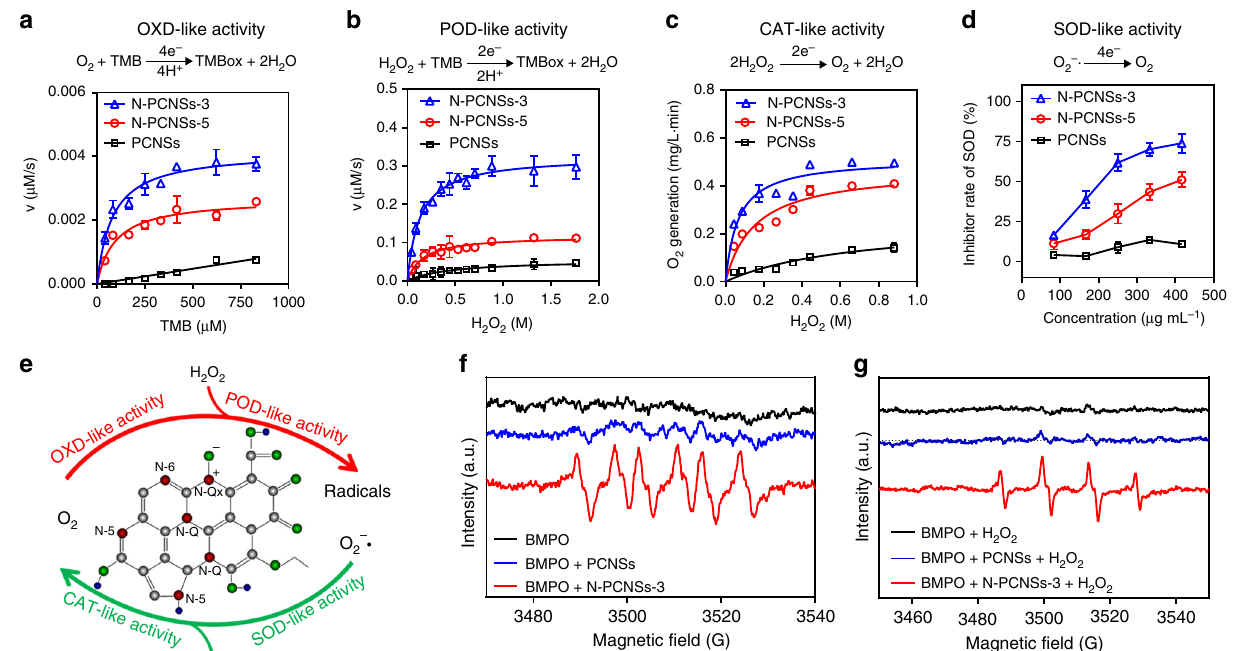
Fig. 2 Enzyme kinetics of N-PCNSs. a Kinetics for OXD-like activity of N-PCNSs. b Kinetics for POD-like activity of N-PCNSs. c Kinetics for CAT-like activity of N-PCNSs. d SOD-like activity of N-PCNSs. e Schematic presentation of enzyme-like activities of N-PCNSs. f , g Generation of both superoxide radicals during OXD-like catalysis as well as hydroxyl radicals during POD-like catalysis. Error bars shown represent the standard error derived from three independent